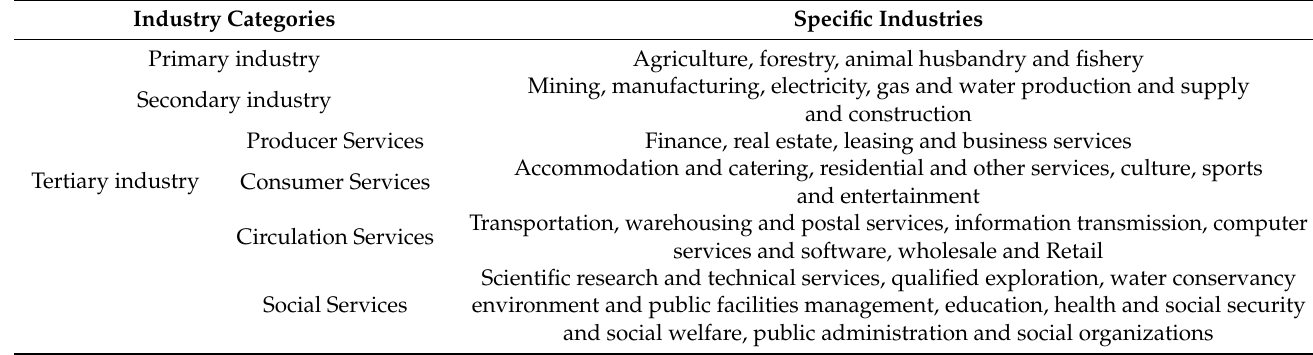
Table 2. Classification of industry categories and more specific